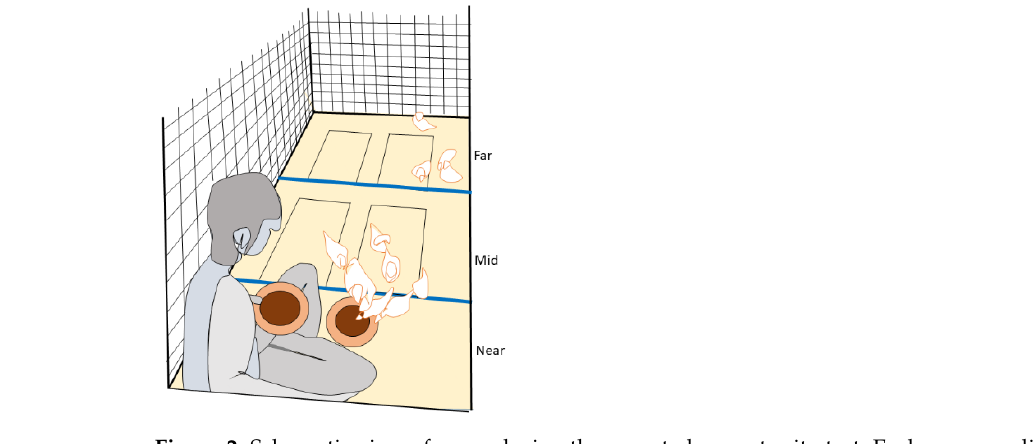
Figure 2. Schematic view of a pen during the repeated opportunity test. Each pen was divided into three areas: “far”, “mid”, and “near”. During the second phase (the last three repetitions), a tester sat down with legs crossed in the pen, placing one feed bowl on the ground and one in her lap, as illustrated.